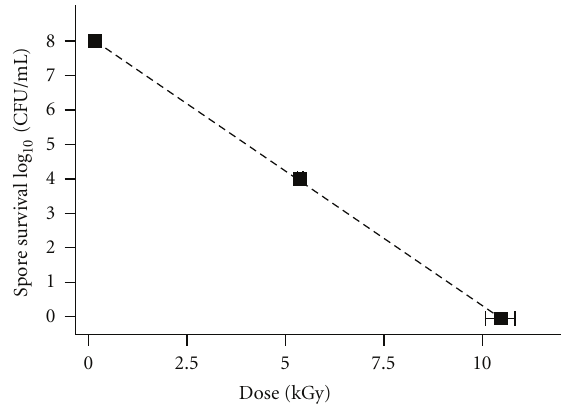
Figure 2: Inactivation of B. atrophaeus spores as a function of electron beam irradiation dose ( n = 3). Linear regression ( r 2 = 0 . 999) extrapolation produced a D 10 value of 1.3 kGy. Error bars in both the X - and Y -axis directions indicate the accuracy in the measurements of dose and colony counts,